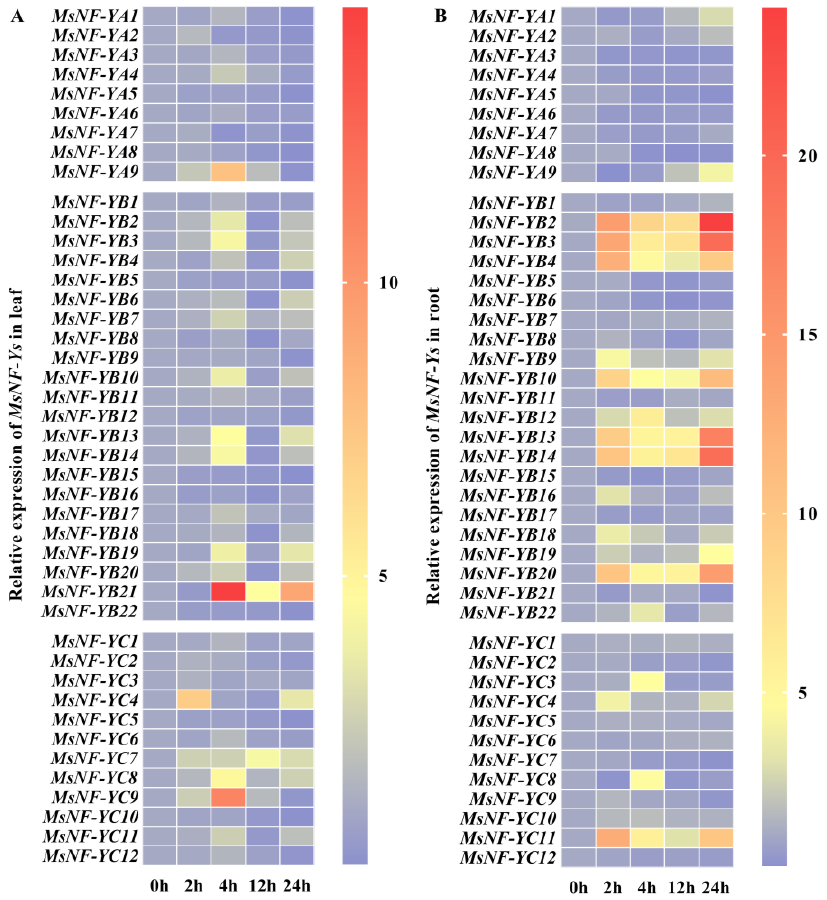
Figure 3. MsNF-Ys of the leaves and roots behaved differently in response to drought stress. The heat map shows the relative mRNA level of MsNF-Y genes in the leaves and roots under drought treatment, compared to the expression level of MsNF-Y genes under 0 h treatment. ( A ) The expression of MsNF-Y genes in the leaves under drought treatment. ( B ) The expression of MsNF-Y genes in the roots under drought treatment. Apple Histone H3 was chosen for the internal quantification control of MsNF-Y genes. The expression of each MsNF-Y gene in the leaves and roots at 0 h treatment was normalized to 1.